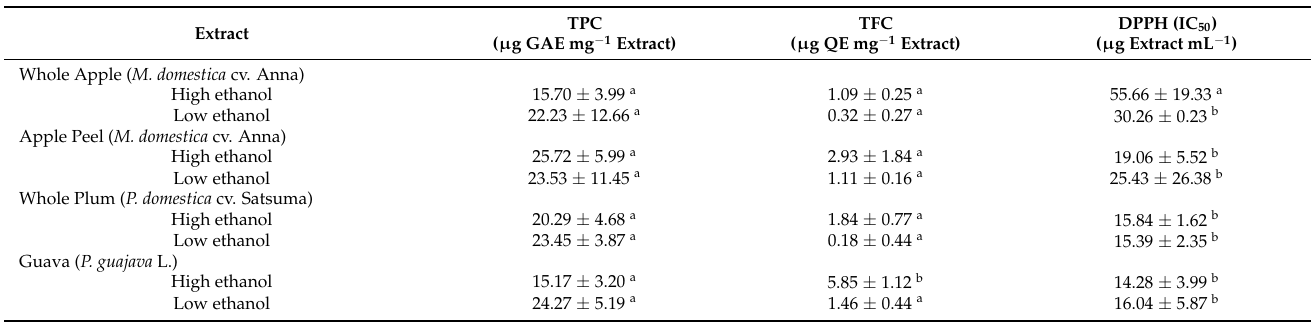
Table 1. Total polyphenol content (TPC), total flavonoid content (TFC), and relative percentage DPPH inhibition of apple ( M. domestica cv. Anna), plum ( P. domestica cv. Satsuma), and guava ( P. guajava L.) extracts (mean ± SD, n = 6).